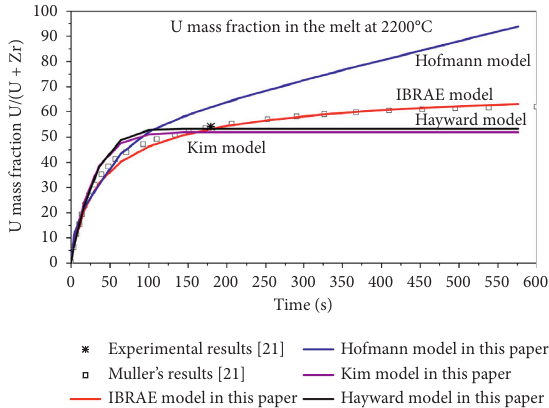
Figure 8: U mass fraction in the melt changes with time at 2200 ° C.